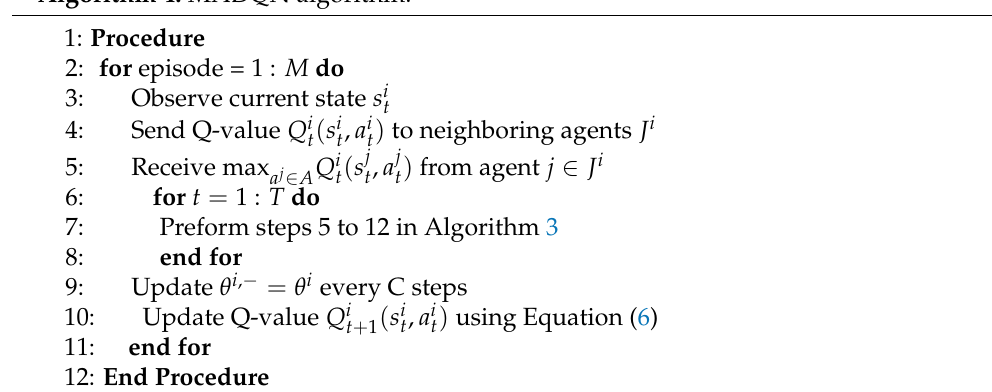
Algorithm 4: MADQN